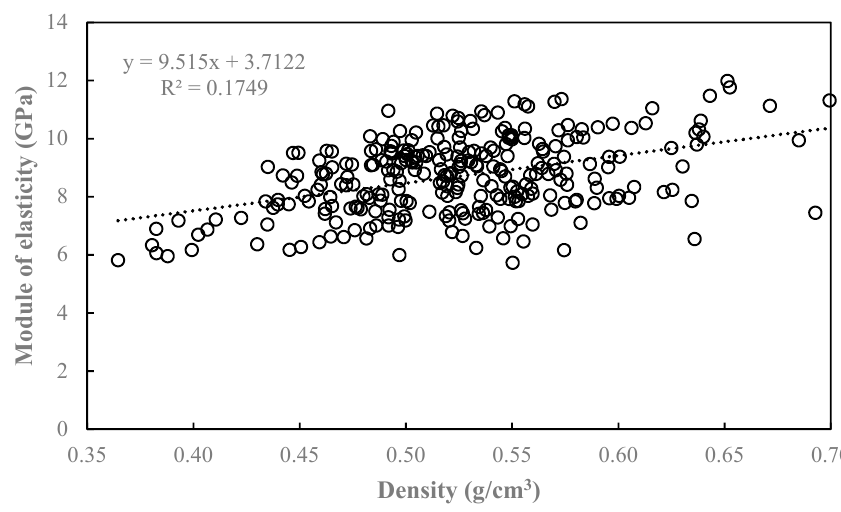
Figure 10. Relationship between module of elasticity and density.